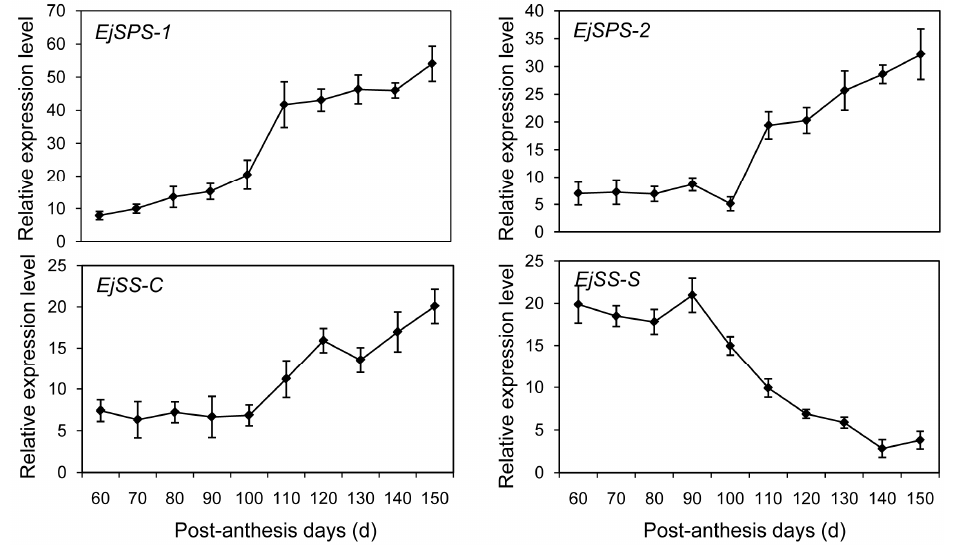
Figure 5. Expression profiles of loquat sucrose synthase and sucrose phosphate synthase ( EjSPS and EjSS ) using qRT-PCR during fruit development. Each point is the mean of three determinations. Vertical bars, if larger than symbols, represent the standard error of the mean ( n = 3).